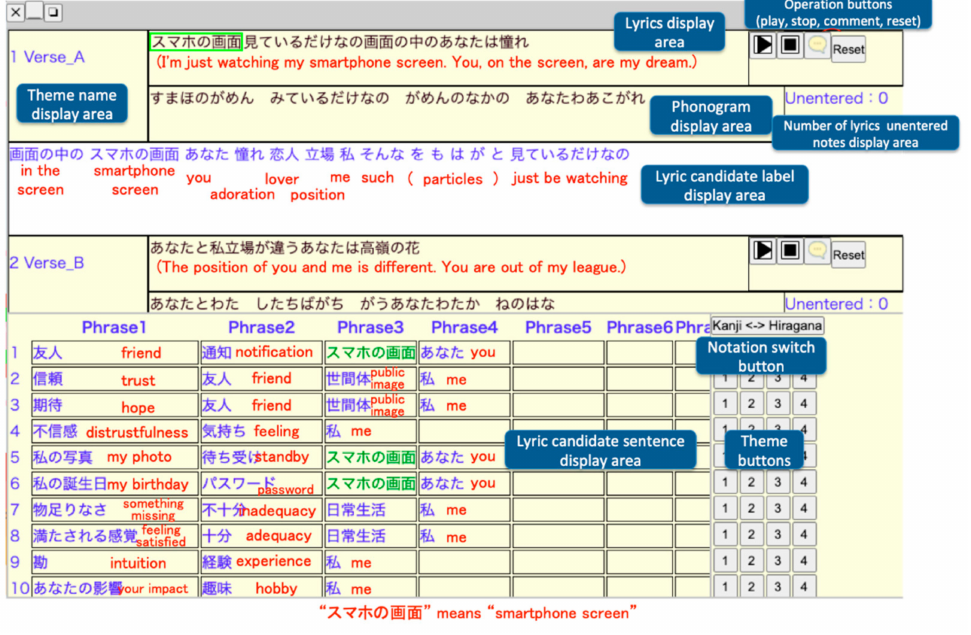
Figure 2. Lyric editing window. (The black texts in the lyrics display area and the blue texts in the lyric candidate label display area and the lyric candidate label display area are the Japanese lyric keywords entered by participants C and D in Table 1. The black texts in the phonogram display area are the phonograms of the texts in the lyrics display area, which are automatically generated. The authors added the names of each area in white on dark blue and the English translations of the Japanese texts in